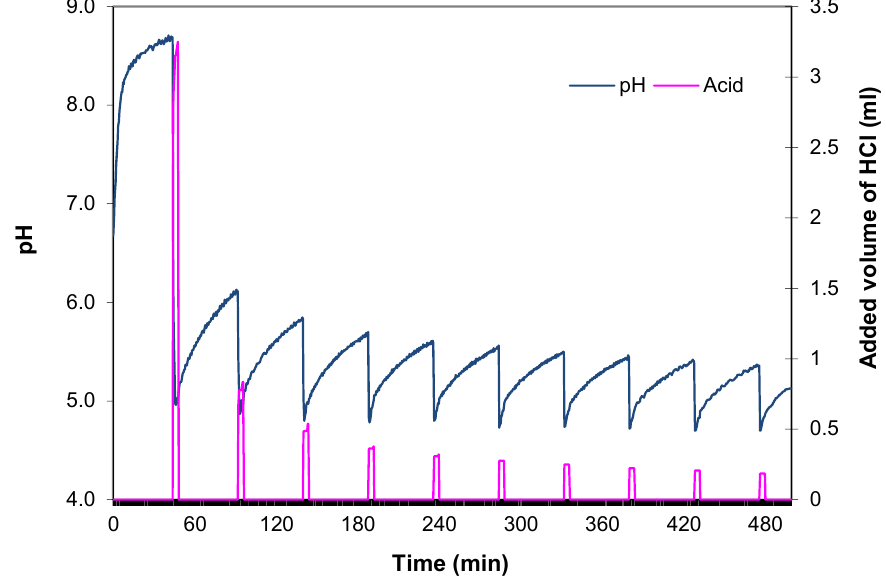
Figure 3. Acid neutralizing capacity of biochar from wood chips as determined by titration. The blue line is the pH; the pink spikes are the acid dosage.